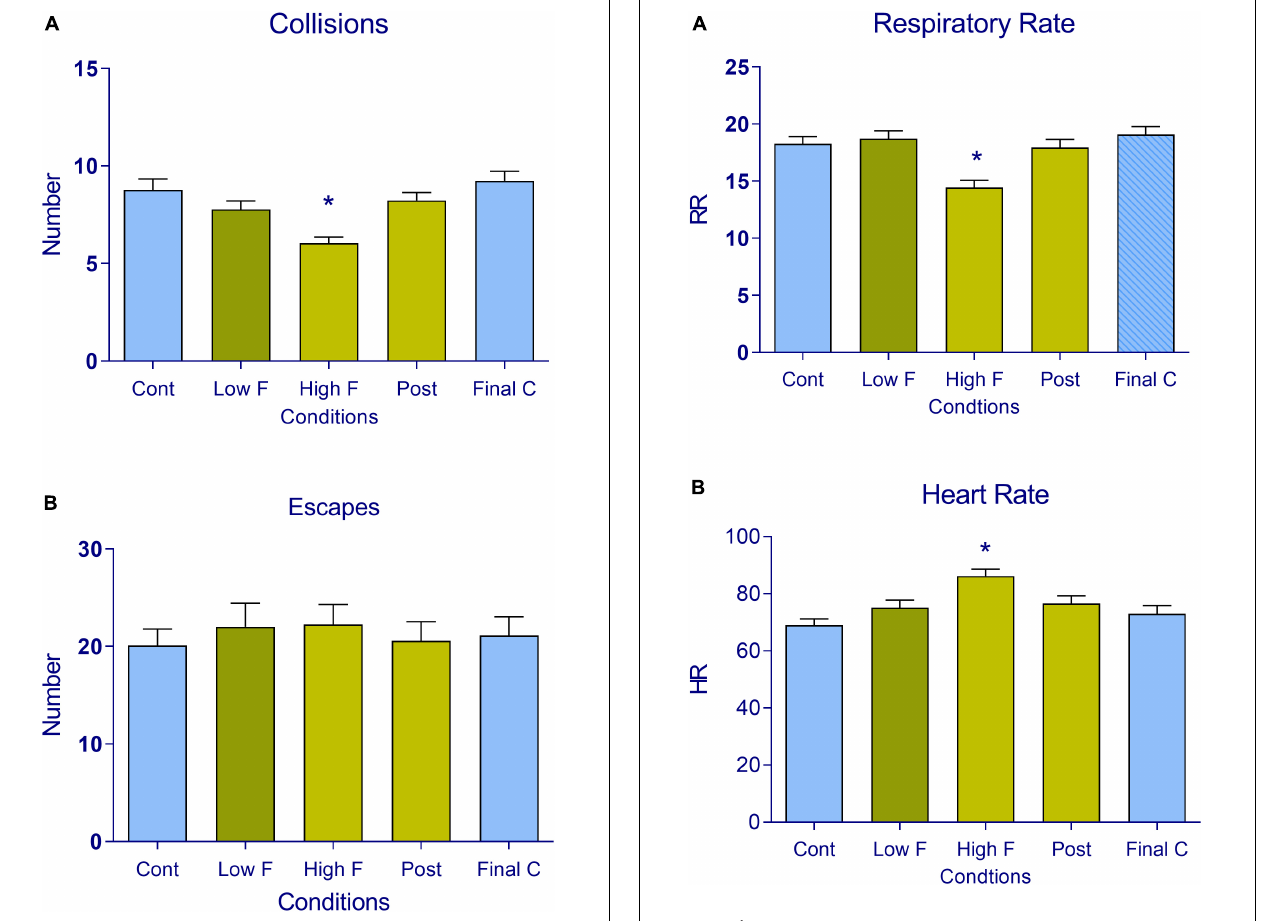
FIGURE 3 | (A) Respiratory rate and (B) heart rate in subjects during the virtual reality task. The data are expressed as mean + SEM. n = 22 across the five conditions (control, low fear, high fear, post-encounter, and final control). * p < 0.05, compared with the initial